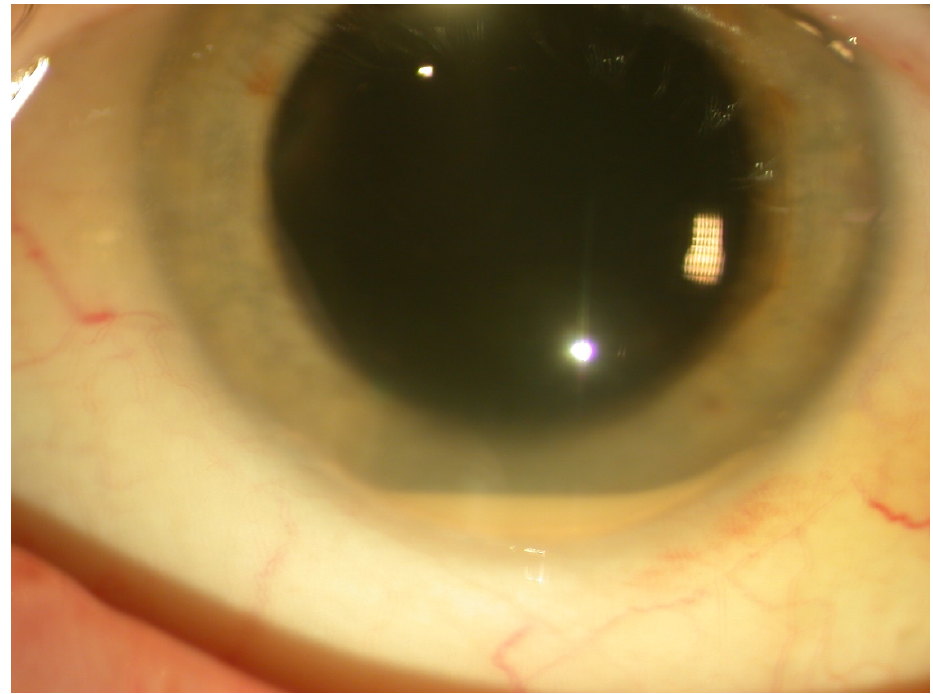
Figure 1. Slit lamp examination of case 1 showing nongranulomatous corneal precipitates with a cellular anterior chamber reaction and hypopyon.